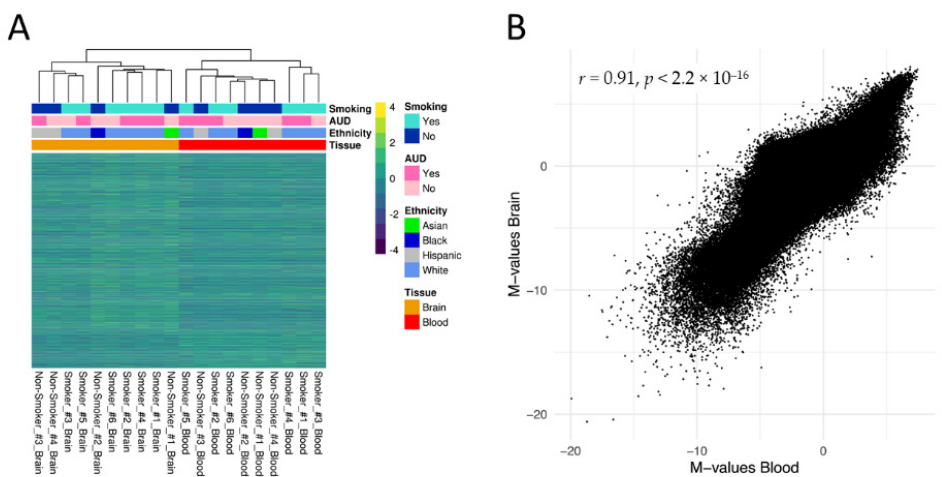
Figure 2. ( A ) Hierarchical clustering of matched blood and Brodmann Area 9 (BA9) brain samples ( n = 10) based on methylation M-values (row normalized) of the n = 632,086 CpG sites remaining after quality control. Next to the tissue type, smoking status, alcohol use disorder status and ethnicity are displayed as additional phenotypic variables. ( B ) Pearson correlation of mean M-values in the between-subject correlation analysis using matched blood and BA9 brain samples.